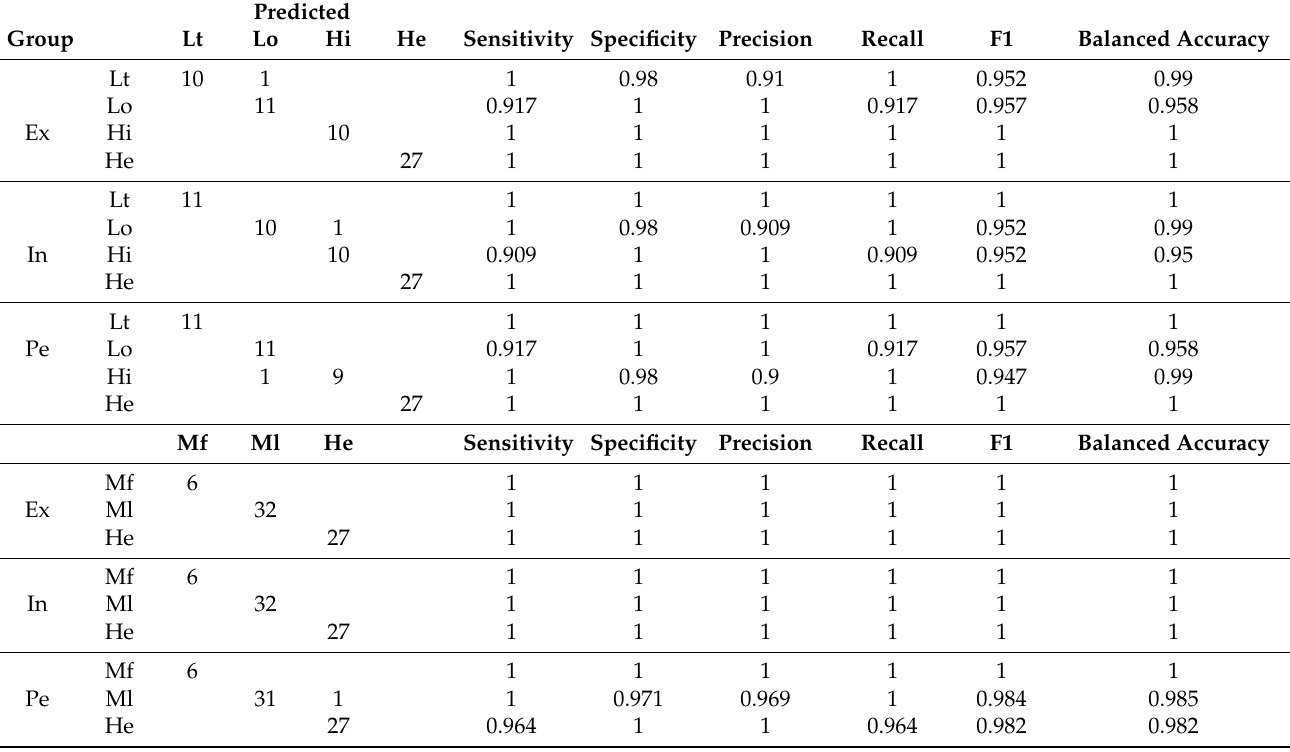
Table 3. Confusion matrices and partial least squares support vector machine (PLS-SVM) classification results for detection of Meloidogyne luci and M. fallax in potato tubers using hyperspectral imaging. Lt: latent infestation; Lo: Low infestation;